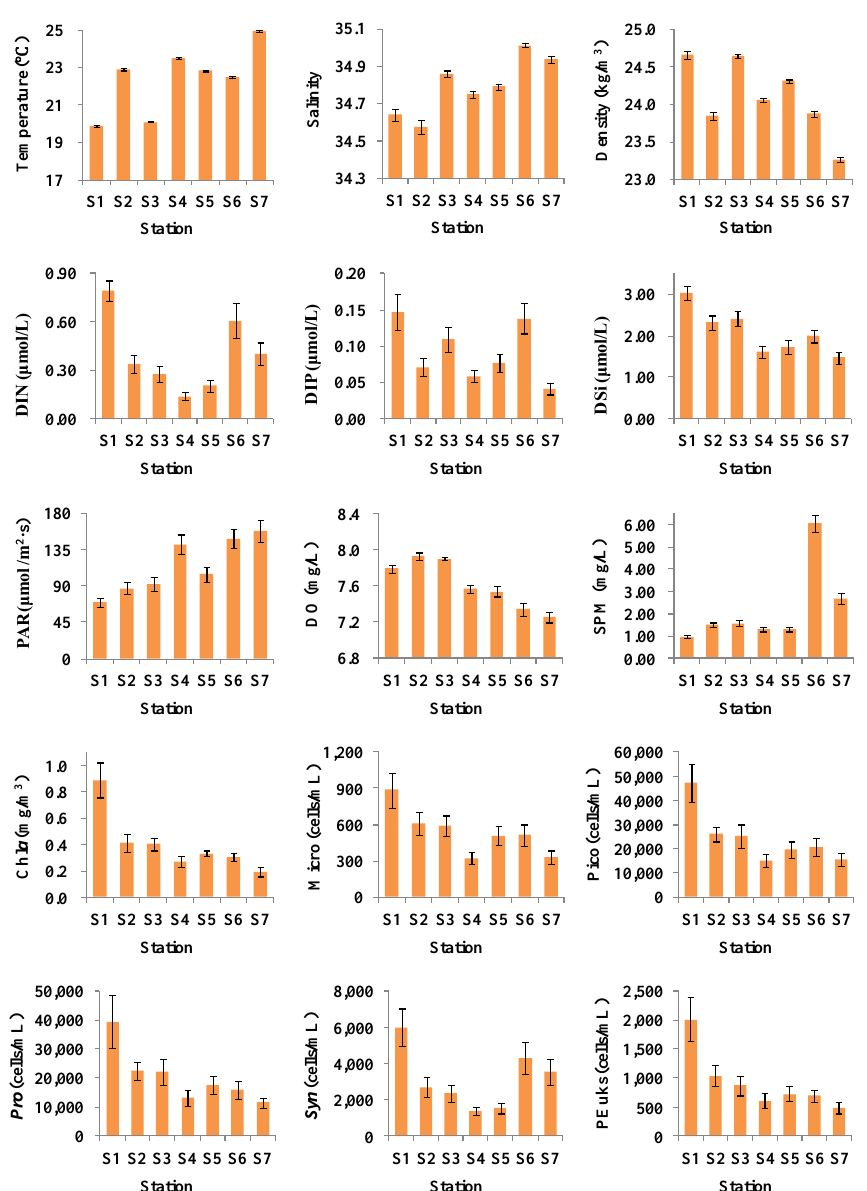
Figure 3. Depth-integrated mean and standard deviation of biogeochemical variables within the euphotic zone at different stations in the northwestern